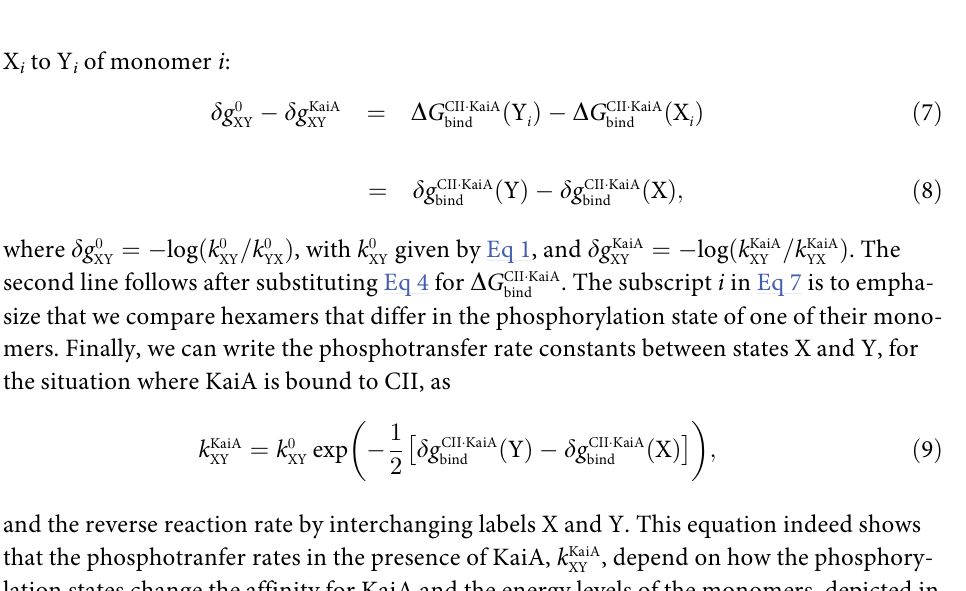
¼ (cid:0) log ð k 0 = k 0 Þ and XY XY YX